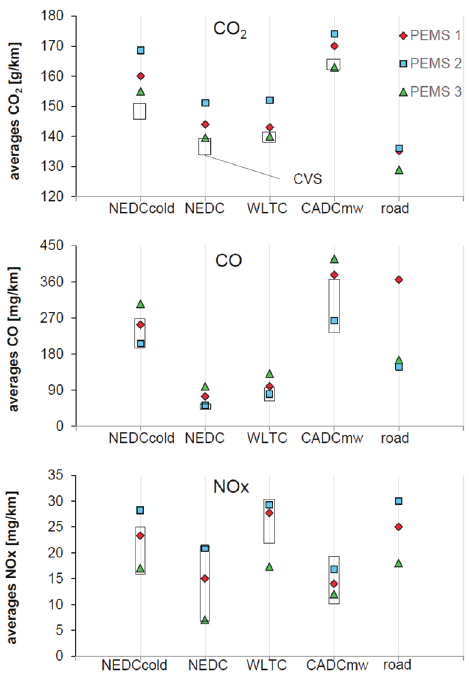
Fig. 10. Comparisons of average values between road trips and cycles on chassis dynamometer. PEMS 1, 2, 3; Seat Leon 1.4 TSI Euro 5b Testing of Diesel cars with PN-PEMS